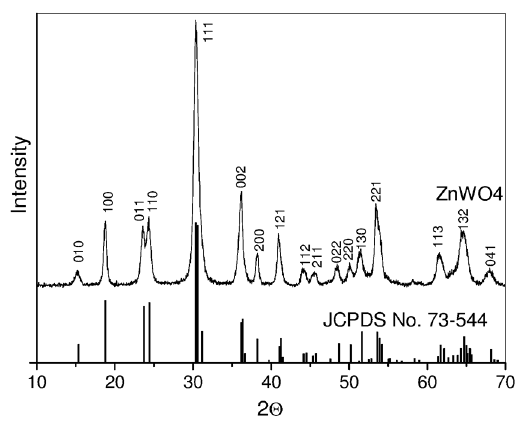
Figure 1: XRD pattern of ZnWO hydrothermal crystallization. Inset at figure: ZnWO according to JCPDS card No. 73-544.